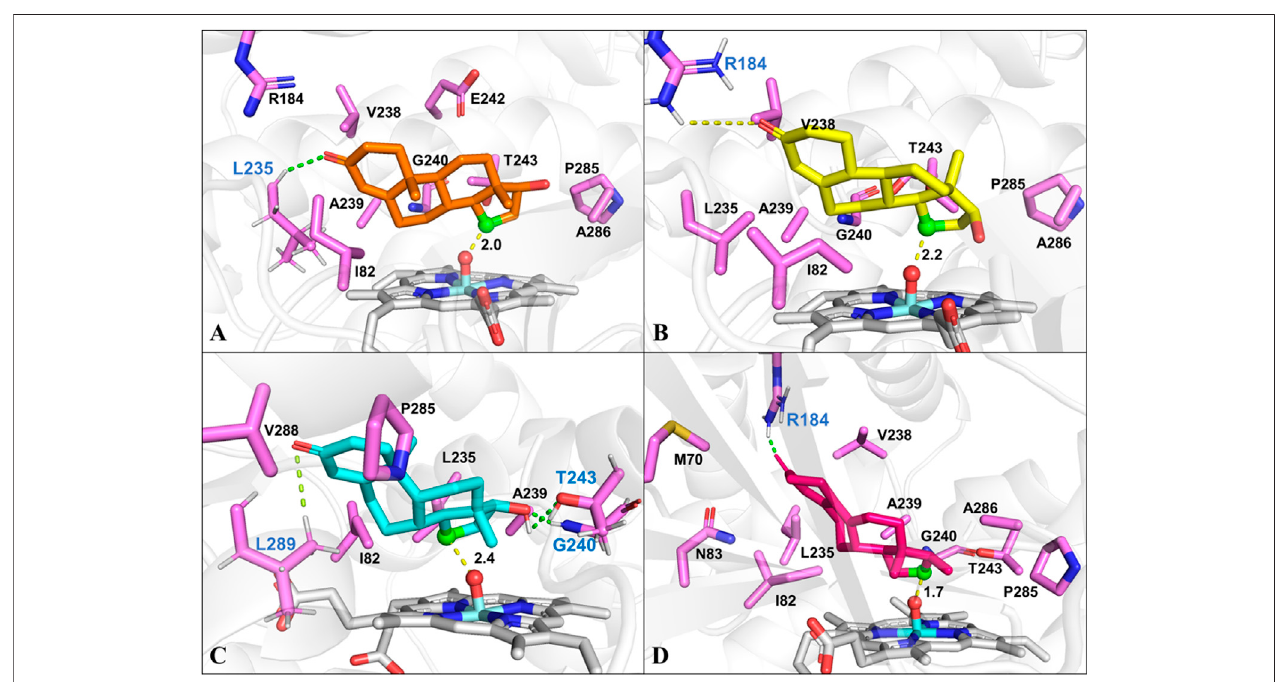
FIGURE 3 | The docked conformation of steroid substrates in the active pocket of CYP109B1 (PDB ID: 4RM4). (A) : Testosterone. (B) : Nandrolone. (C) : Boldenone. (D) : 9 (10) dehydronandrolone .Key residues in active pocket of CYP109B1 are colored in violet and residues forming hydrogen bonds are labeled in blue. Theimportantdistanceinthefavorabledockedposesaregiveninangstrom(Å).TheC15atomofsteroidsubstratesaredisplayedingreenwithballstyleandtheOxatom of Cpd I are displayed in red with ball style.